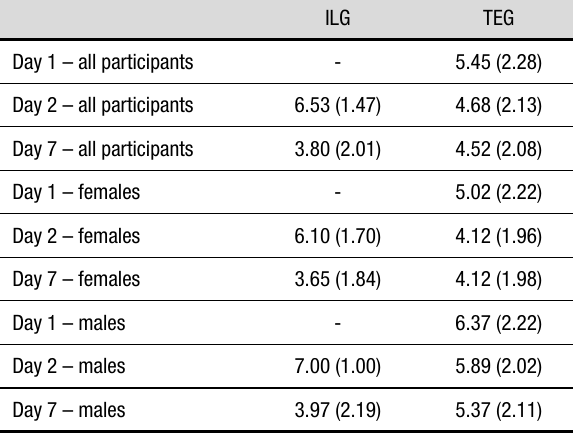
Table 2. Performance of the participants over the days in each group. ILG